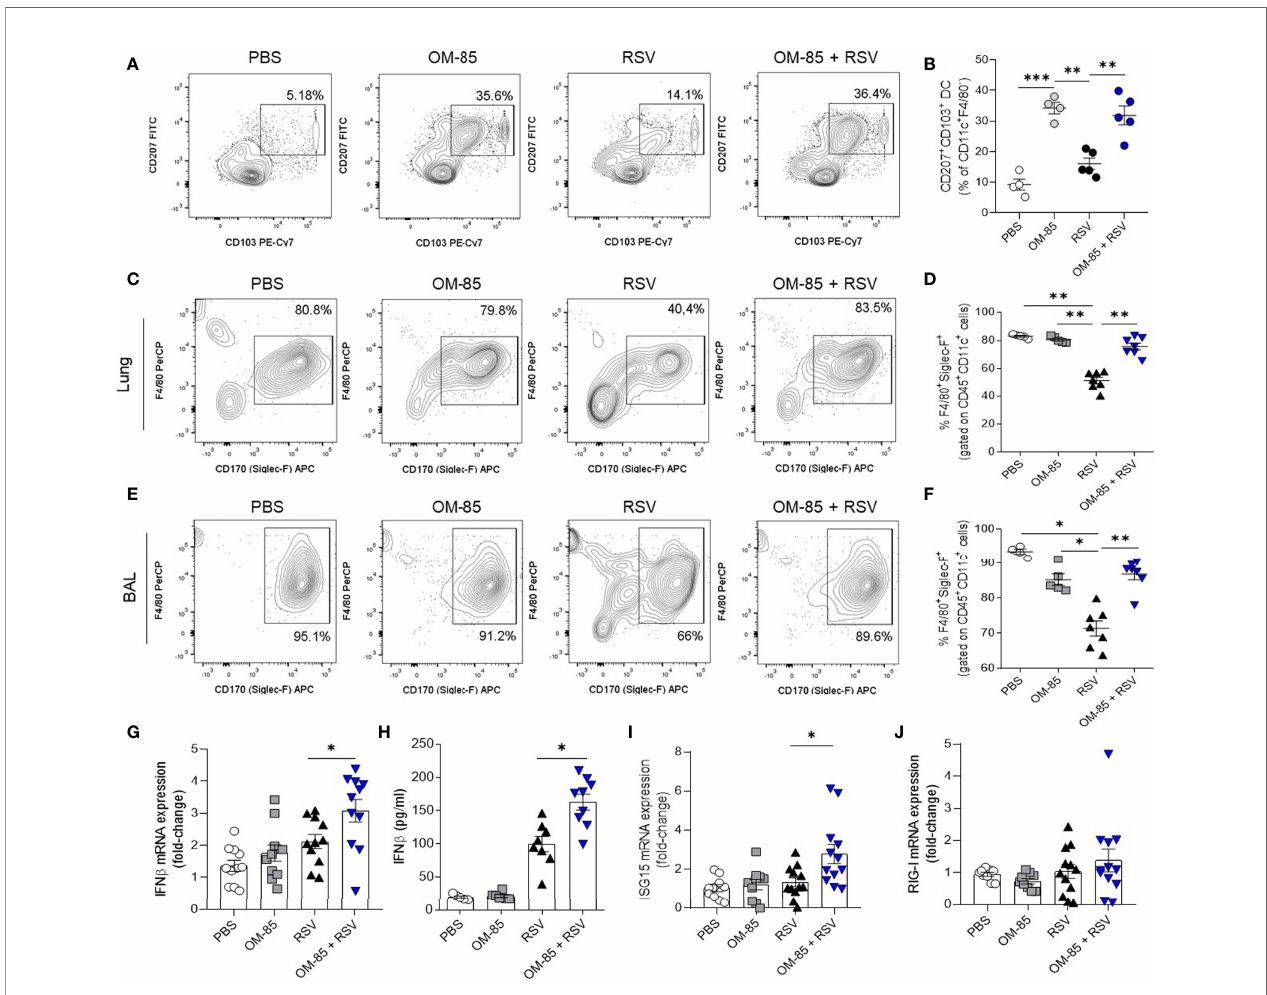
FIGURE 7 | Preventive treatment with OM – 85 expands dendritic cells and alveolar macrophages and contributes do antiviral response improvement. Mice were treated intranasally with OM – 85 (1mg) 5 days prior to RSV infection (four OM – 85 delivery). Afterwards, mice were infected with RSV (1x10 7 PFU/ml) and received another OM – 85 boost 6h later. BAL and lungs were harvested at day 5 post – infection. (A, B) Percentage of CD11c + F4/80 – CD207 + CD103 + conventional dendritic cells in the lung and its representative FACS pro fi le. (C – F) Percentage of + CD11c + F4/80 + Siglec – F + alveolar macrophages in lung and BAL, and its representative FACS pro fi le. (G) Ifnb1 gene expression in the lungs detected by real – time PCR (fold change compared to untreated/uninfected control). (H) Production of IFN b in the lungs measured by ELISA. (I, J) Isg15 and Ddx58 (RIG – I gene) gene expression in the lungs detected by real – time PCR (fold change compared to untreated/ uninfected control). All data are expressed as mean±SEM. Multiple groups were compared using Kruskal – Wallis. * p <0.05. ** p <0.01, *** p